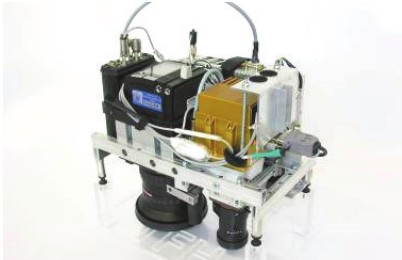
Figure 2. Aerial Camera System SMAP